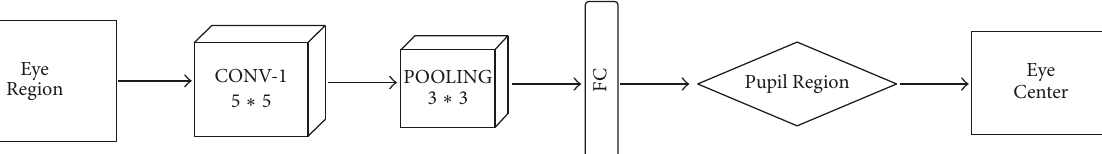
Figure 5: Structure of the 2nd CNNs.